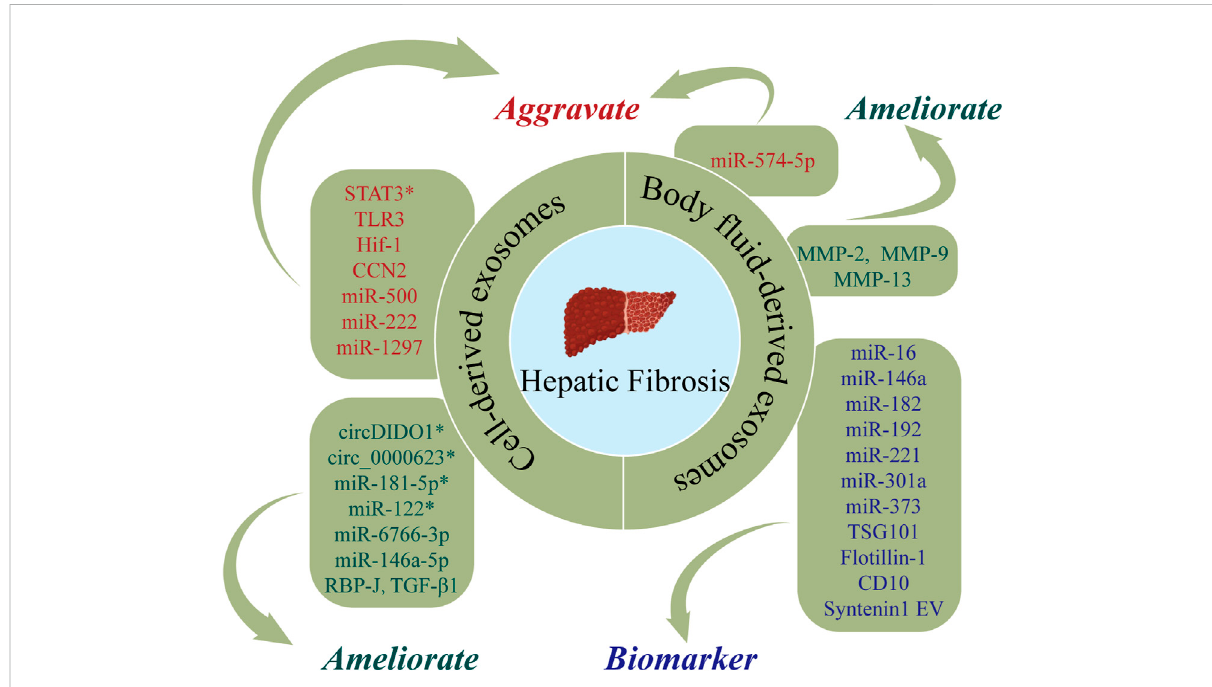
FIGURE 4 The roles of nucleic acids and proteins carried by exosomes in hepatic fi brosis (HF). Nucleic acids or proteins that may aggravate HF are highlightedinred,amelioratingHFarehighlightedingreen,andbiomarkersarehighlightedinpurple.*referstonucleicacidsandproteinscarriedby exosomes from mesenchymal stem